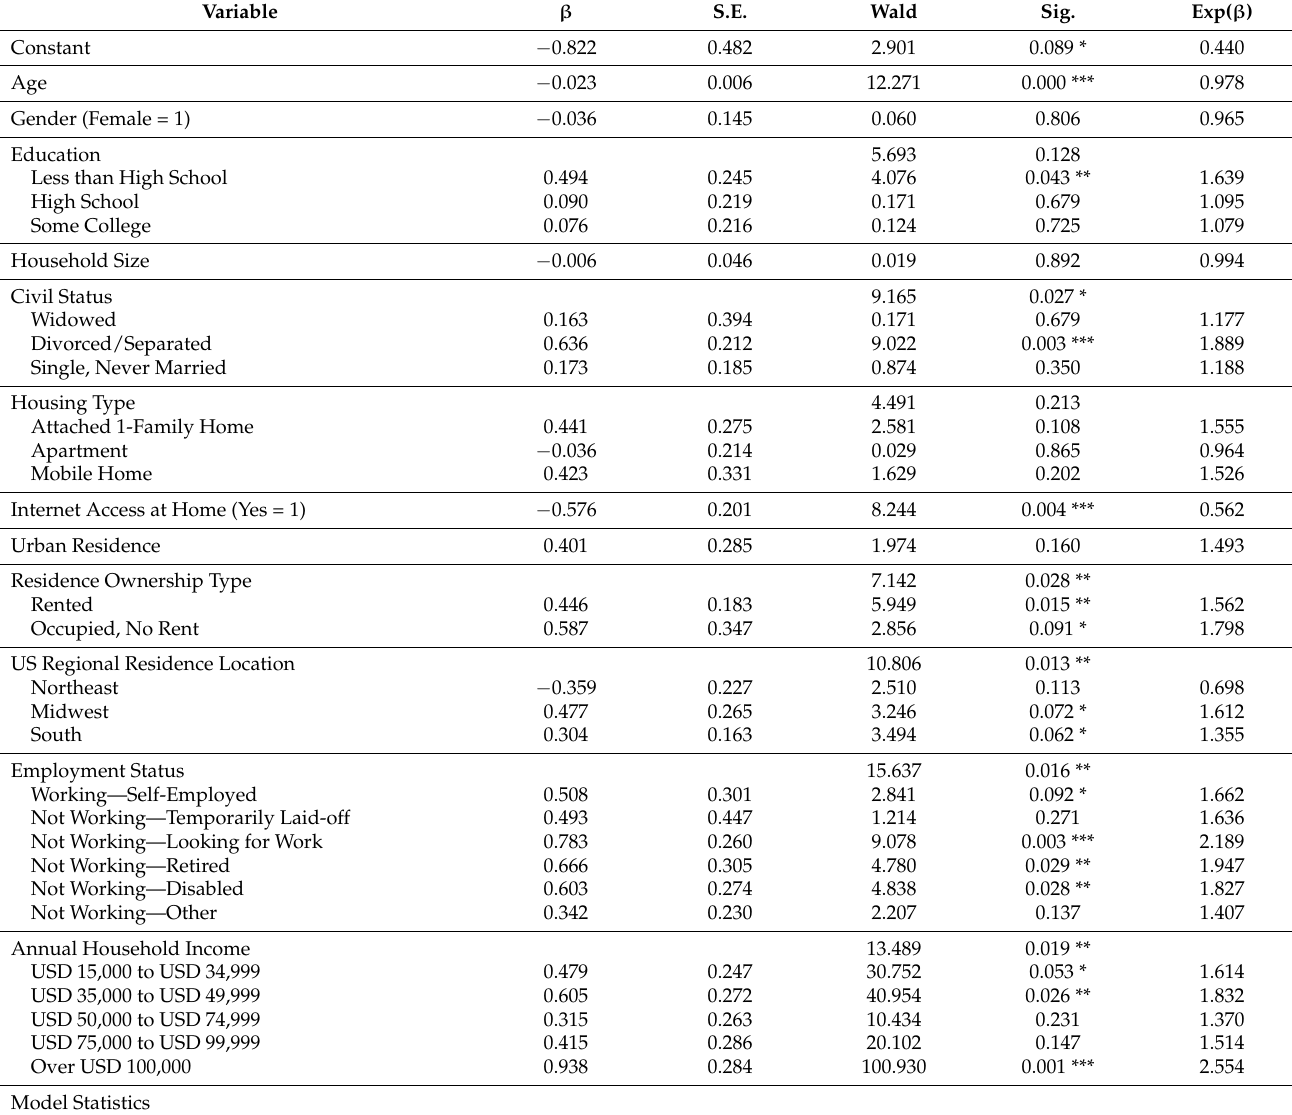
Table 11. Logistic Regression of Hispanic EIWA (EIWA Participants =